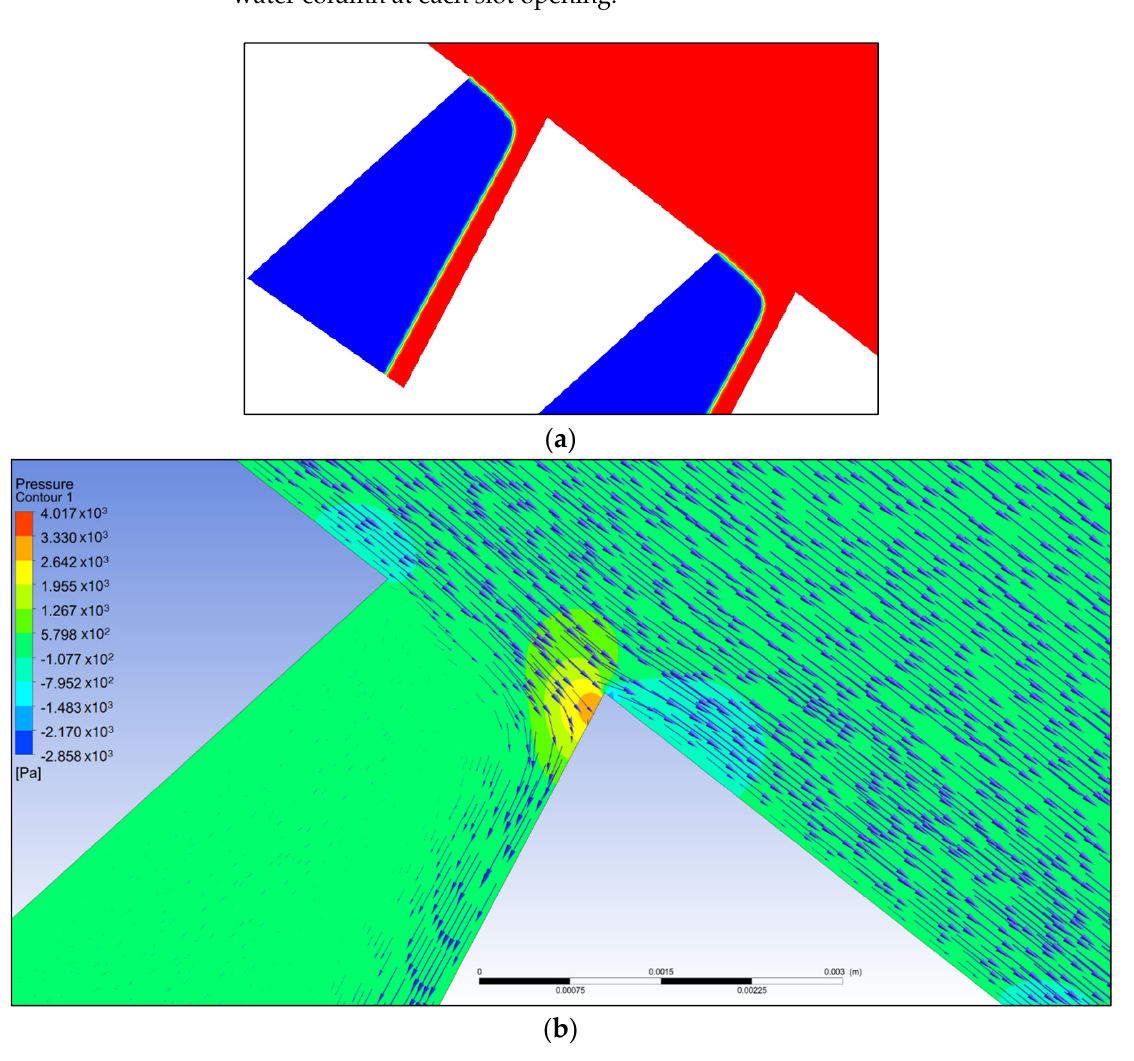
Figure 12. CFD simulation results of the triangular wire screen: ( a ) two ‐ phase contour volume fraction; ( b ) vectors velocity and pressure contours.